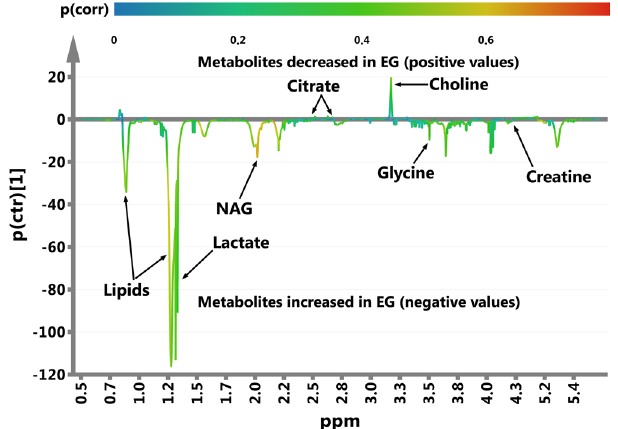
Figure 3. The OPLS-DA s-line plot indicating the metabolites that differentiate the epileptic, EG, and non- epileptic, RG, groups. The correlation of particular metabolites towards segregation between the EG and RG groups (p(corr)) is assessed according to the associated color